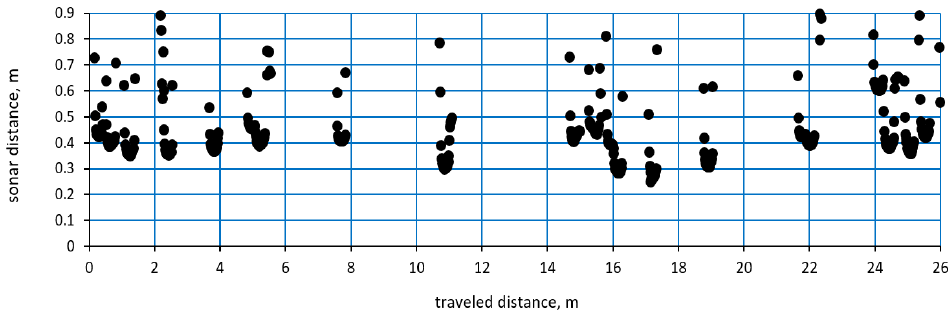
Figure 6. Sonar values detected at the outdoor test (vineyard).